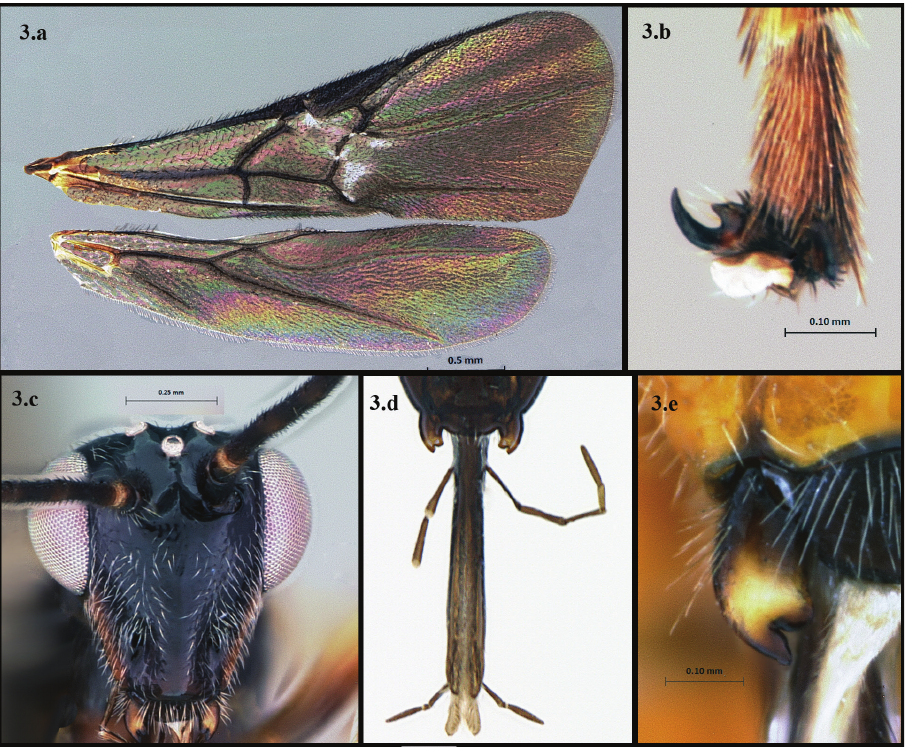
Figure 3. Lingualongis species-group a wings b hind claw c anterior head d mouthparts e